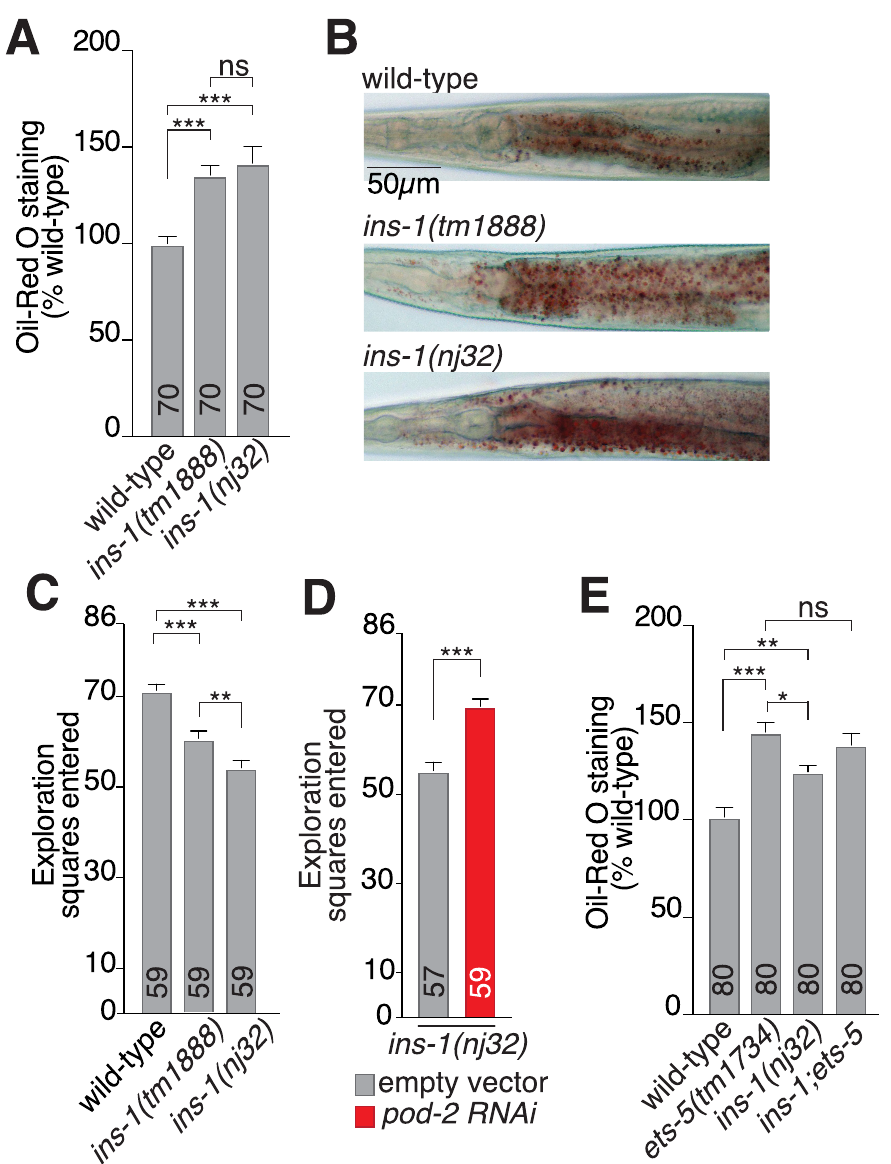
Fig 4. INS-1 controls intestinal fat levels. (A) Quantification of ORO staining of wild-type, ins-1(tm1888) and ins-1 (nj32) animals. Data presented as ORO intensity as % wild-type, � x + SEM, n shown within bar. Significance assessed by 1-way ANOVA (Dunnet’s correction). (B) Representative ORO images of wild-type, ins-1(tm1888) and ins-1(nj32) animals. Scale bar 50 μ m. (C) Exploration assay of wild-type, ins-1(tm1888) and ins-1(nj32) animals. Data presented as � x + SEM, n shown in bar. Statistical significance assessed by 1-way ANOVA with Tukey’s correction for multiple comparisons. (D) Exploration assay of ins-1(nj32) animals on RNAi plates, treated with either empty vector control (gray) or RNAi targeted to pod-2 (red). Data presented as � x + SEM, n shown in bar. Statistical significance assessed by unpaired t test. (E) Double mutant analysis for ets-5(tm1734) and ins-1(nj32) . ORO quantification of ins-1(nj32); ets-5 (tm1734) double mutant compared to each single mutant. Data presented as � x + SEM, n shown within bar. Significance assessed by 1-way ANOVA (Tukey’s correction). For all data: ns, not significant ( p > 0.05), � = p � 0.05, �� = p � 0.01, ��� = p � 0.001. The underlying numerical data can be found in S1 Data. ORO, Oil-Red O; RNAi, RNA interference.